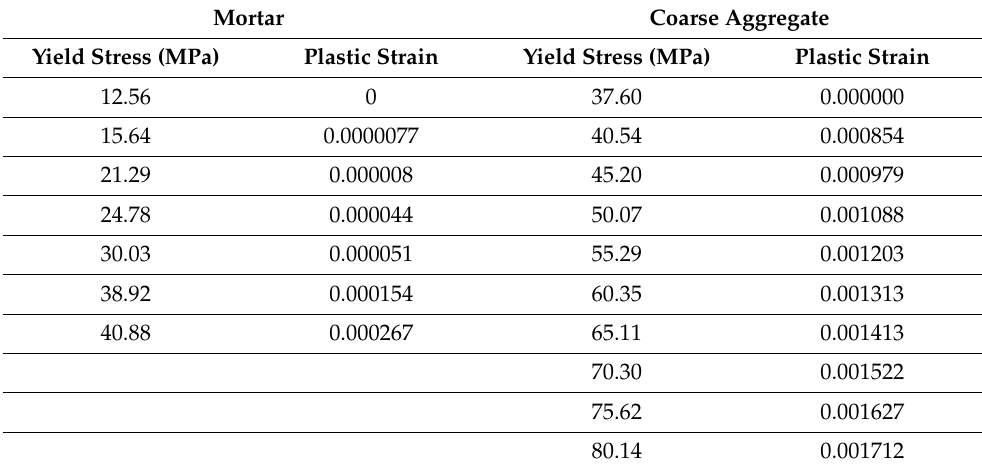
Table 6. Characteristics of yielding on the experimental plastic zone.